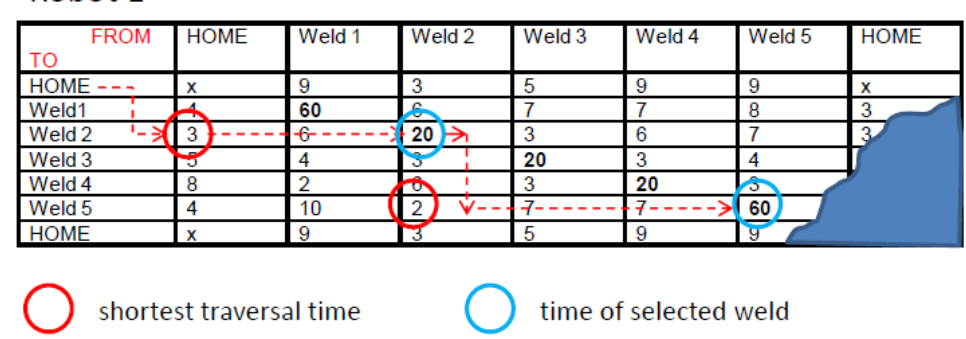
Figure 2. Self-organization matrix with time data in seconds (example).